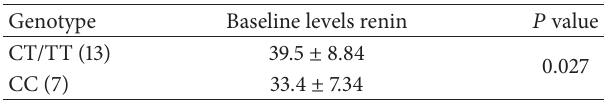
Table 7: Difference of renin levels based on genotype in salt diet